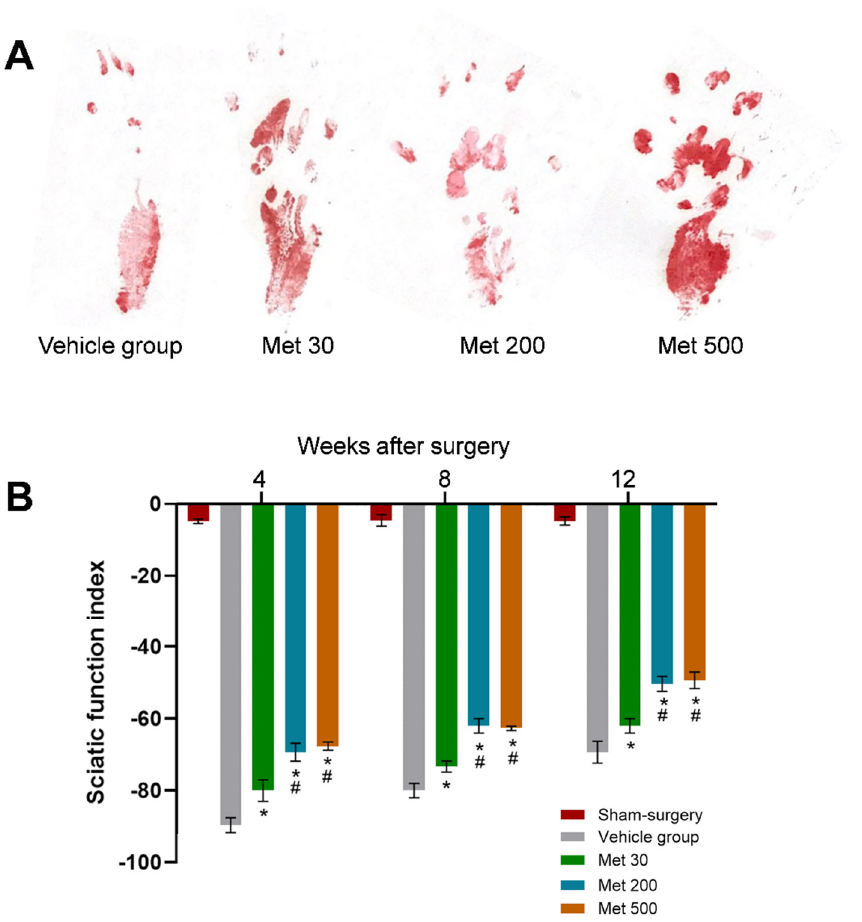
Figure 3. The SFI in each group. ( A ) Representative images of operative left footprints 12 weeks following the operation; ( B ) SFI values 4, 8 and 12 weeks following the operation. All data are expressed as the mean ± standard error of mean. * p < 0.05 for comparison to the vehicle group. # p < 0.05 for comparison to rats with metformin at low dose (30 mg/kg).